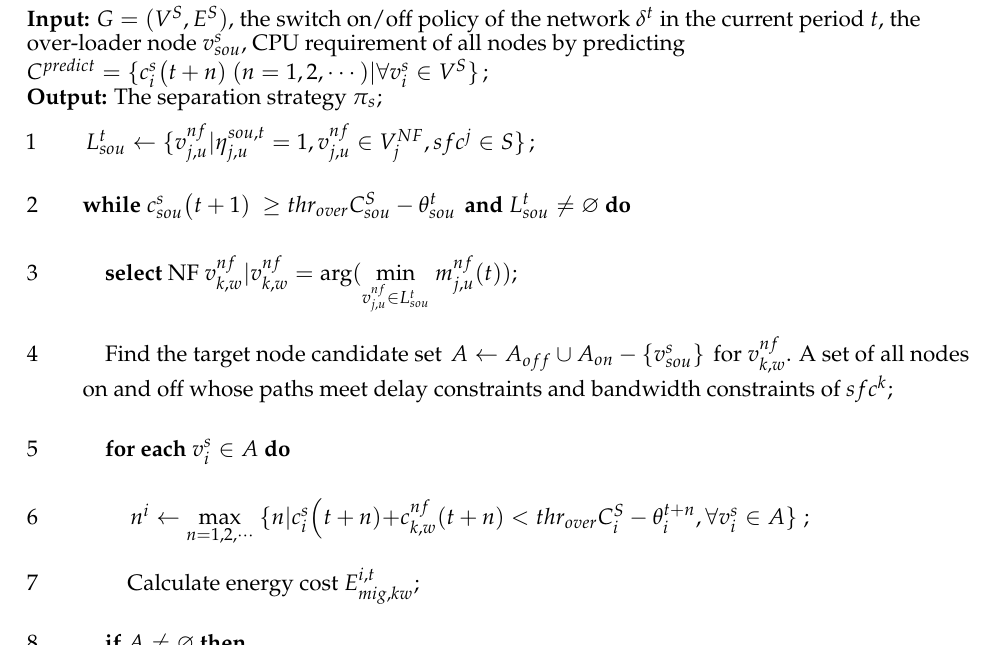
Algorithm 2 Resource Prediction Based Network Function Separation